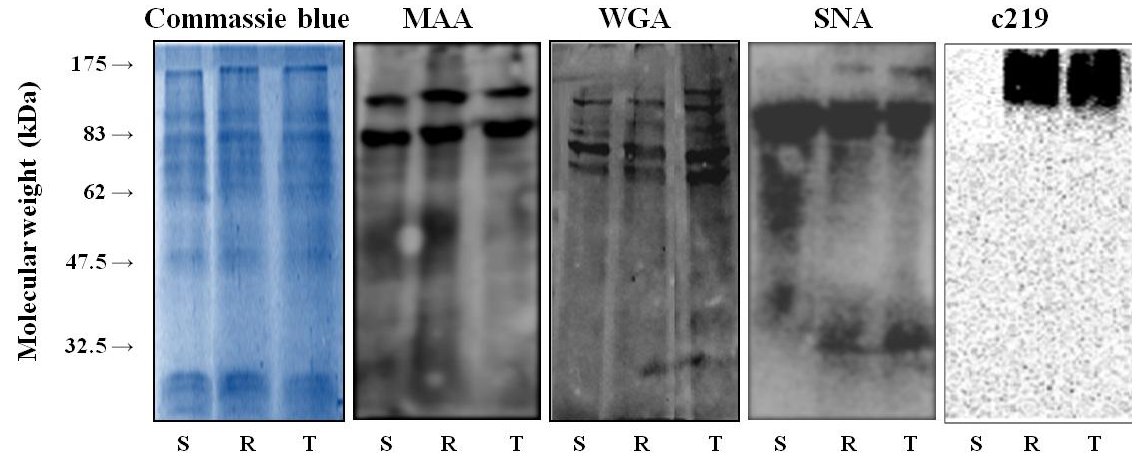
Figure 1. Detection of protein bands in the crude membrane fraction of S, R and T cells by Commassie blue staining of polyacrylamide gels. Wheat germ agglutinin (WGA), Maackia amurensis agglutinin (MAA) and Sambucus nigra agglutinin (SNA) were detected using lectin blots and western blotting with the c219 anti-P-gp antibody. Polyacrylamide gels were stained with Commassie blue as a control for the accuracy of protein loading. These data are representative of three independent